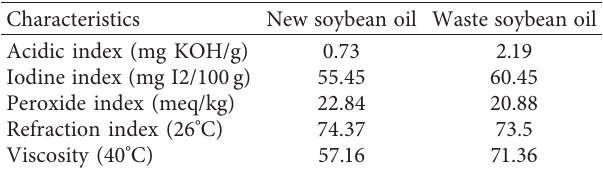
Table 5: Soybean oil’s physical and chemical behavior.